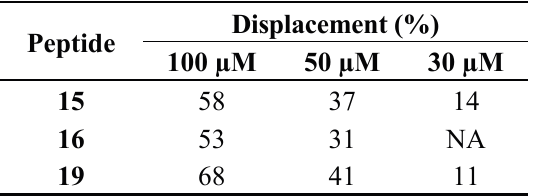
Table 2. Dose dependent inhibition of selected peptides on VEGFR1 binding measured by ELISA. The values are the average of at least 3 tests each in triplicate. NA means no